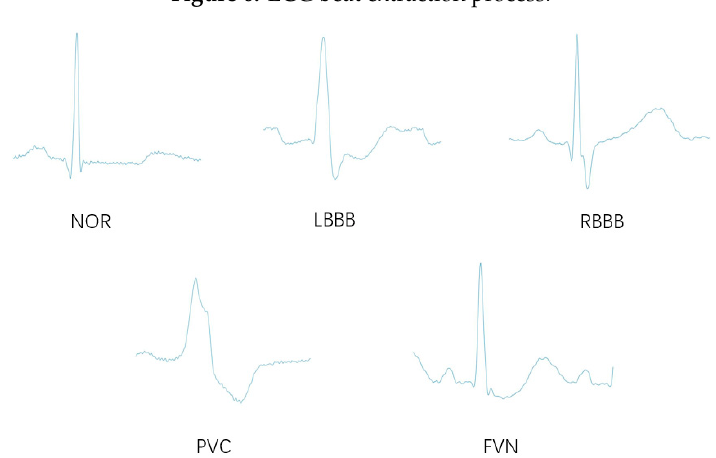
Figure 7. Normal beat and four ECG arrhythmia beats.